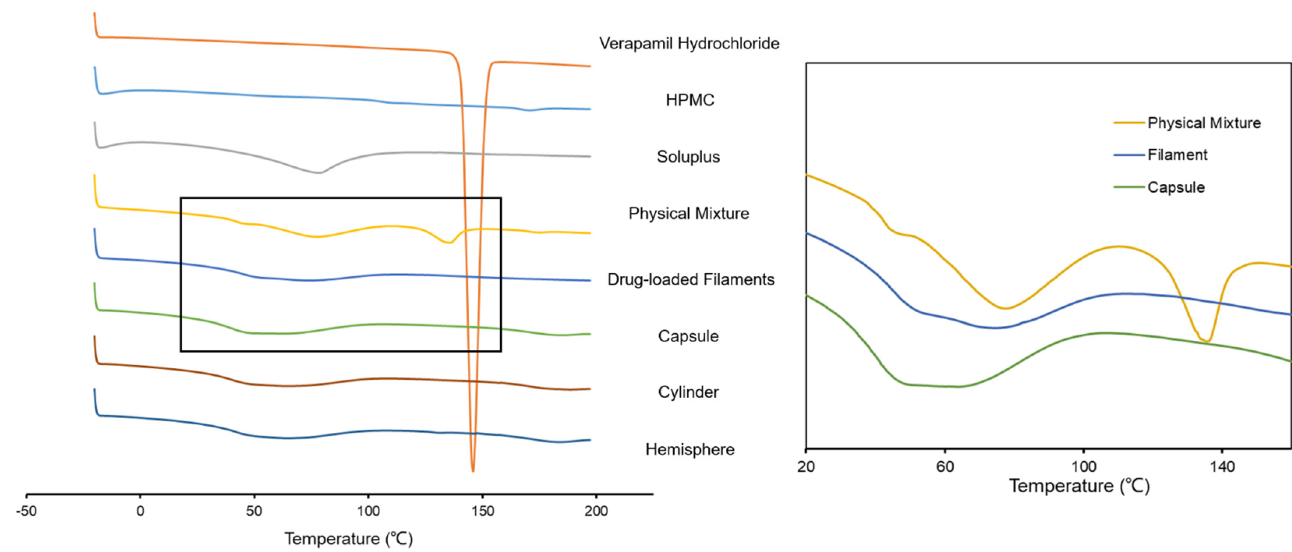
Figure 8. DSC results of verapamil hydrochloride, HPMC, Soluplus, physical mixture, drug-loaded filaments and formulations.